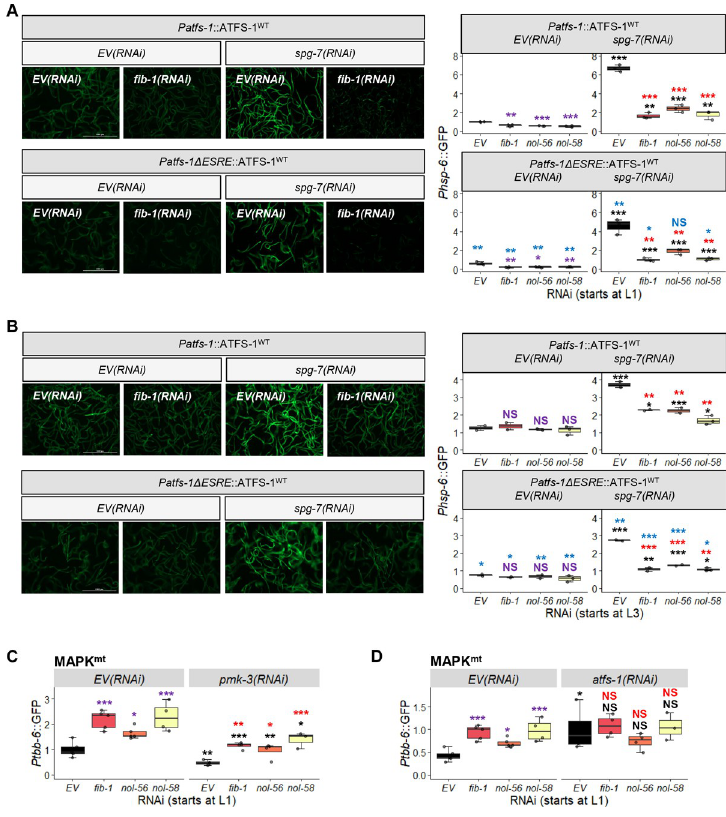
Fig 3. Disruption of box C/D snoRNPs affects UPR mt and MAPK mt expression through the ESRE motif. (A-B) Images and (A-D) quantification of GFP fluorescence of C . elegans carrying Phsp-6 ::GFP (A, B) or Ptbb-6 ::GFP (C, D) reporters that were reared on E . coli expressing empty vector ( EV ) or RNAi targeting fib-1/FBL , nol-56/Nop56 , or nol- 58/Nop58 . (A, B) Phsp-6 ::GFP reporter strains were wild-type or crossed with Patfs-1 Δ ESRE ::ATFS-1 WT . RNAi was paired with empty vector ( EV ) or spg-7(RNAi) (A, B) , pmk-3(RNAi) (C) , or atfs-1(RNAi) (D) . Three biological replicates with ~400 worms/replicate were analyzed. (A, B) Representative images are shown on the left. p -values were determined from two-way ANOVA, followed by Dunnett’s test, or Student’s t -test. All fold changes were normalized to EV control. NS not significant, � p < 0.05, �� p < 0.01, ��� p < 0.001. In all panels, purple significance marks indicate comparison between gene(RNAi) and EV(RNAi) in unstressed condition, red marks indicate comparison between gene (RNAi) and EV(RNAi) in stressed condition ( spg-7(RNAi) ), and black marks indicate comparison between stressed and unstressed conditions. Additionally, blue significance marks indicate comparison between Phsp-6 ::GFP expression in Patfs-1 Δ ESRE ::ATFS-1 WT and wild-type